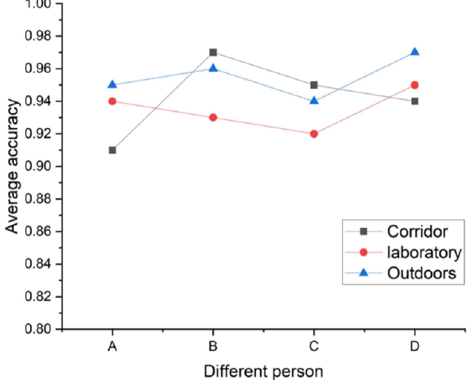
Figure 17. Identification accuracy of different person.